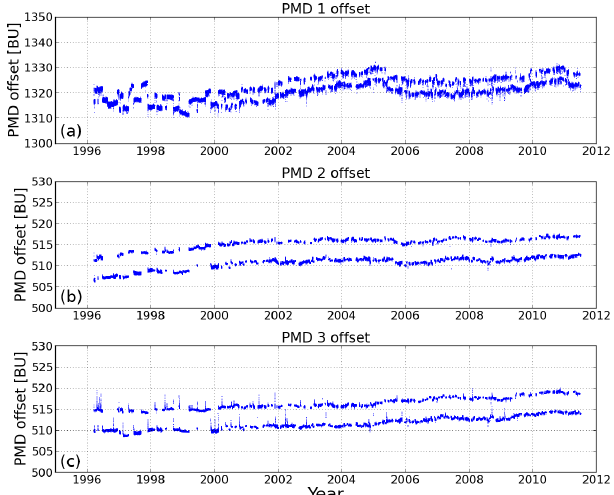
Figure 15. PMD offset in binary units (BU) as a function of time for PMD 1, 2, and 3 (a–c) .